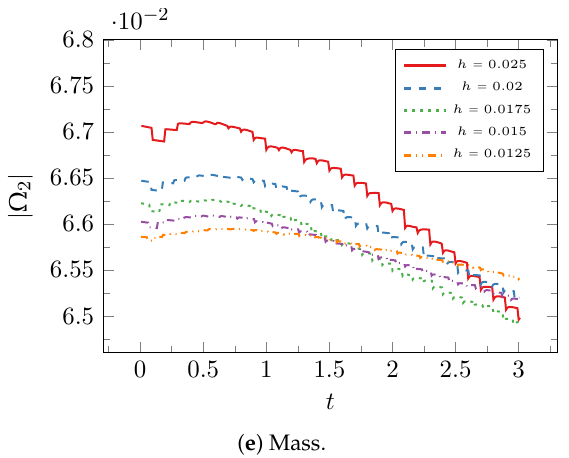
Figure 2. Results for the ellipsoidal test case (case 1).